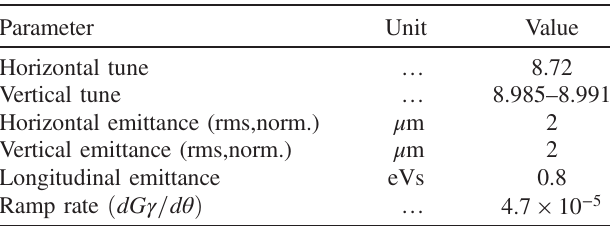
TABLE I. AGS polarized proton beam parameters.